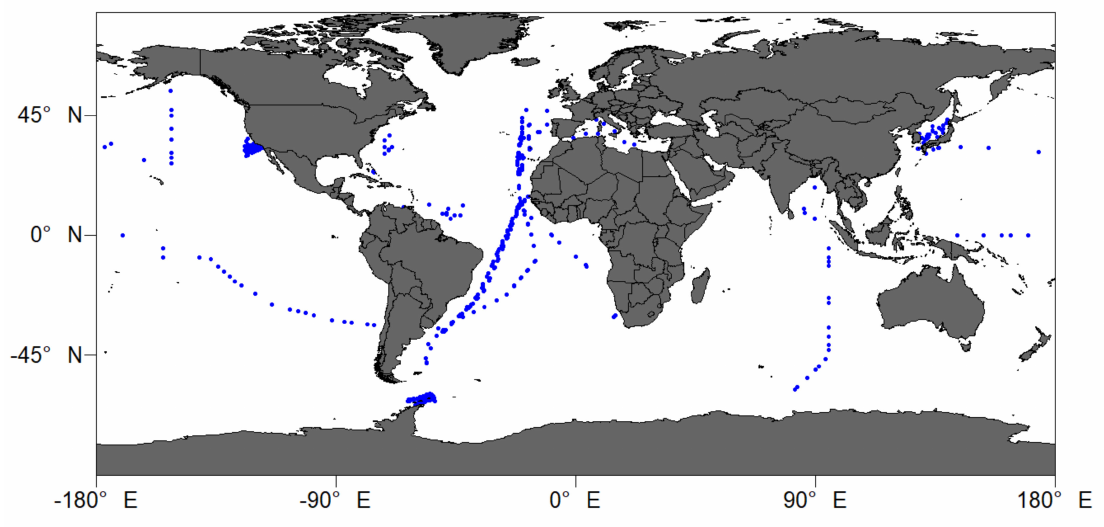
Figure 1. Stations of the NOMAD data